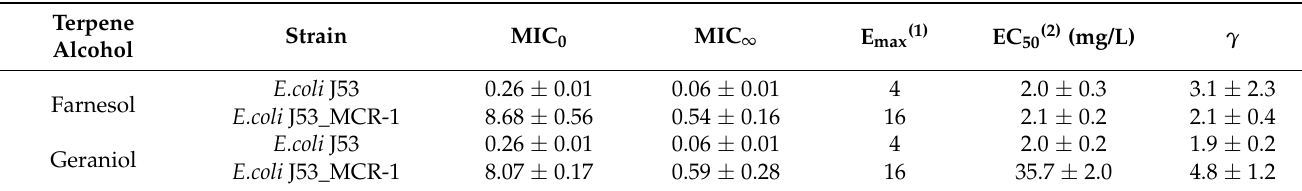
Table 3. E max model fitting parameters values ± SE calculated for curves representing the colistin MIC (mg/L) measured for E. coli J53 or its MCR-1 transconjugant ( E. coli J53_MCR-1) versus farnesol or geraniol concentrations (mg/L). Terpene Alcohol